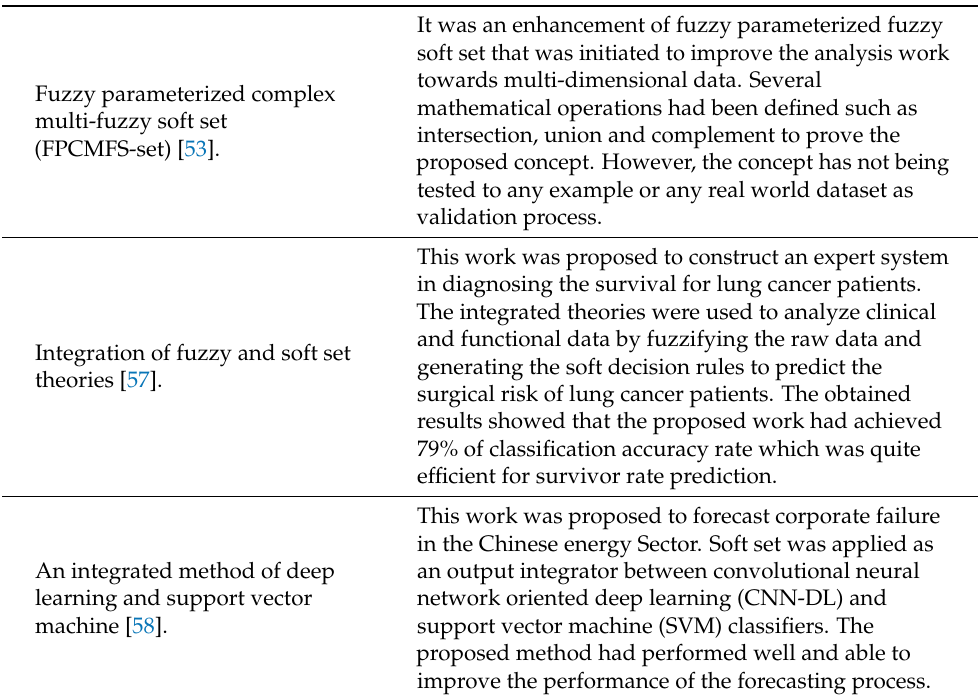
Table 1. Other existing works on hybrid feature selection